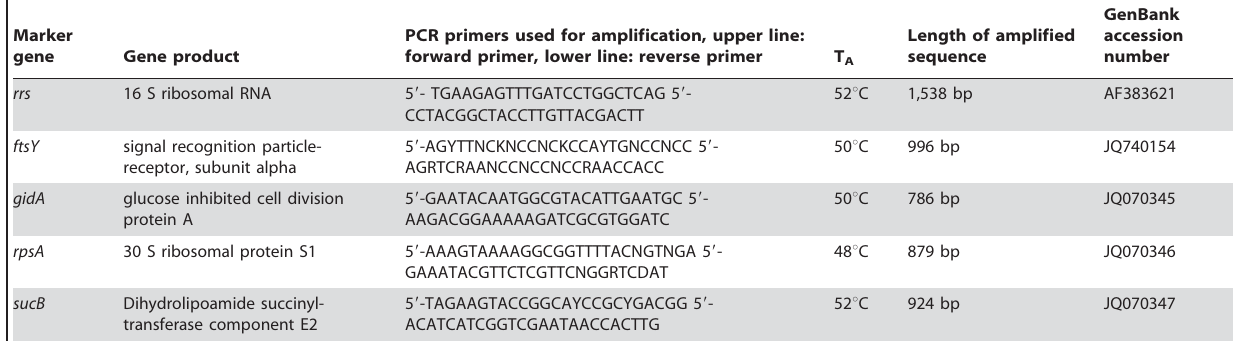
Table 1. MLST marker